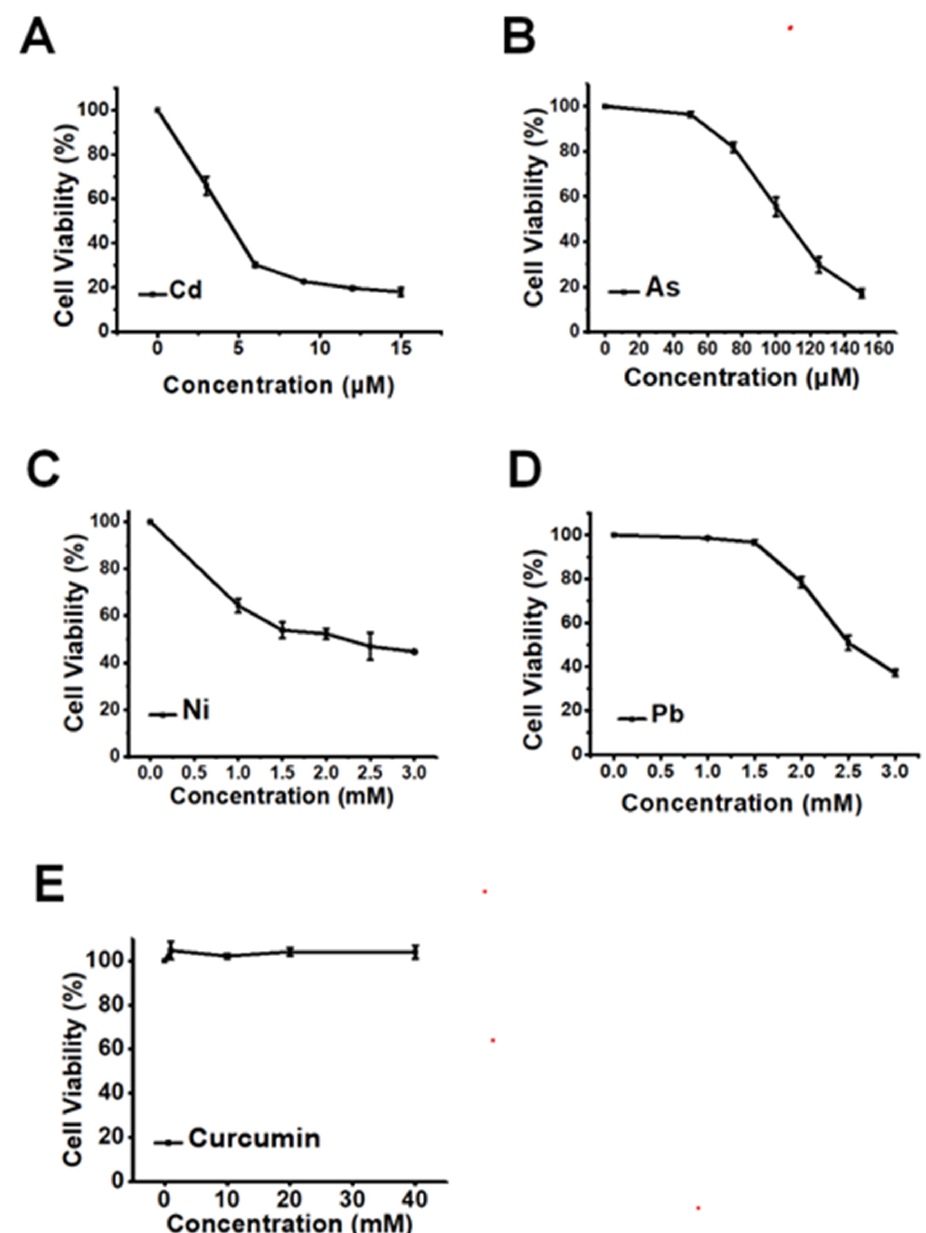
Figure 1. The cytotoxicity of various heavy metals and curcumin in HepG2 cells ( n = 3). The dose- dependent cellular viabilities decline is induced by ( A ) Cd, ( B ) As, ( C ) Ni and ( D ) Pb. ( E ) The cell viability of HepG2 cells exposed to a serious concentration of curcumin.